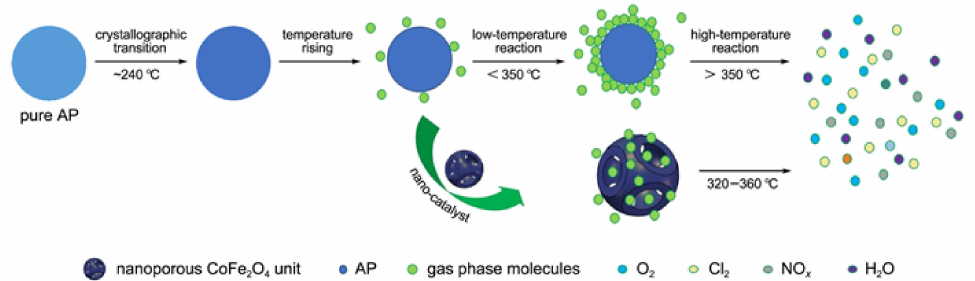
Figure 14. Schematic diagram of the thermal AP decomposition process in the absence and presence of nanoporous CoFe 2 O 4 . Reproduced with the permission of ref. [73]. Copyright 2016, Acta Physico- Chimica